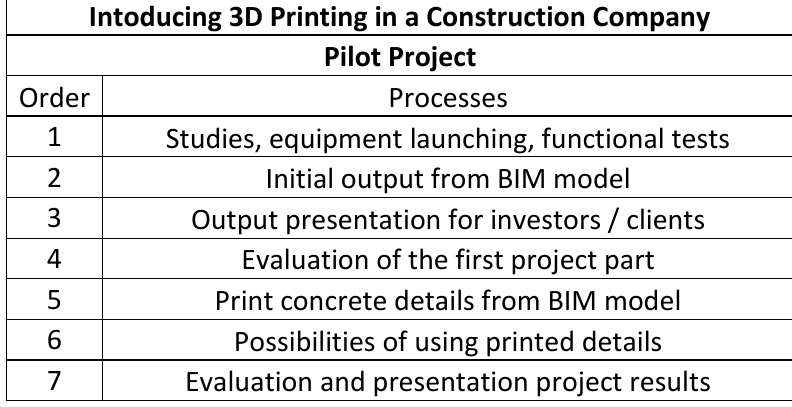
Table 2: Example of Operations Sequence of a Pilot Project Introducing 3D Printing Intoducing 3D Printing in a Construction Company Pilot